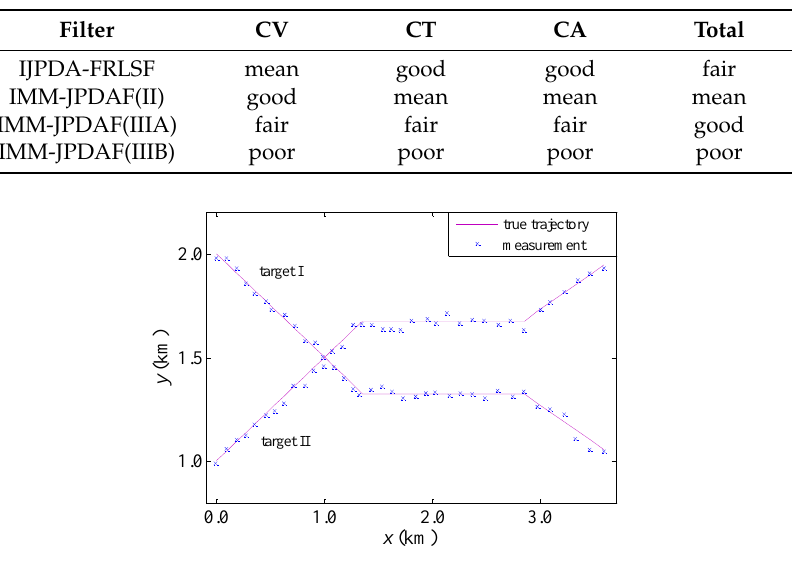
Figure 6 . The true trajectories and measurements.